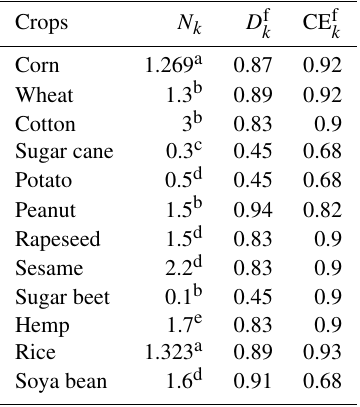
Table 3. Straw-to-product ratio ( N k ), dry matter fraction ( D k ), and combustion efficiency (CE k ) of crop straw used in this